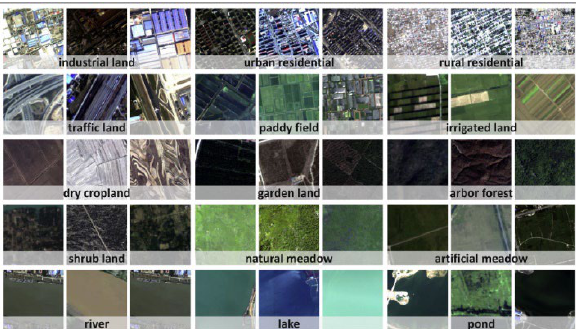
Figure 2 Example of the GID dataset (Tong et al.,